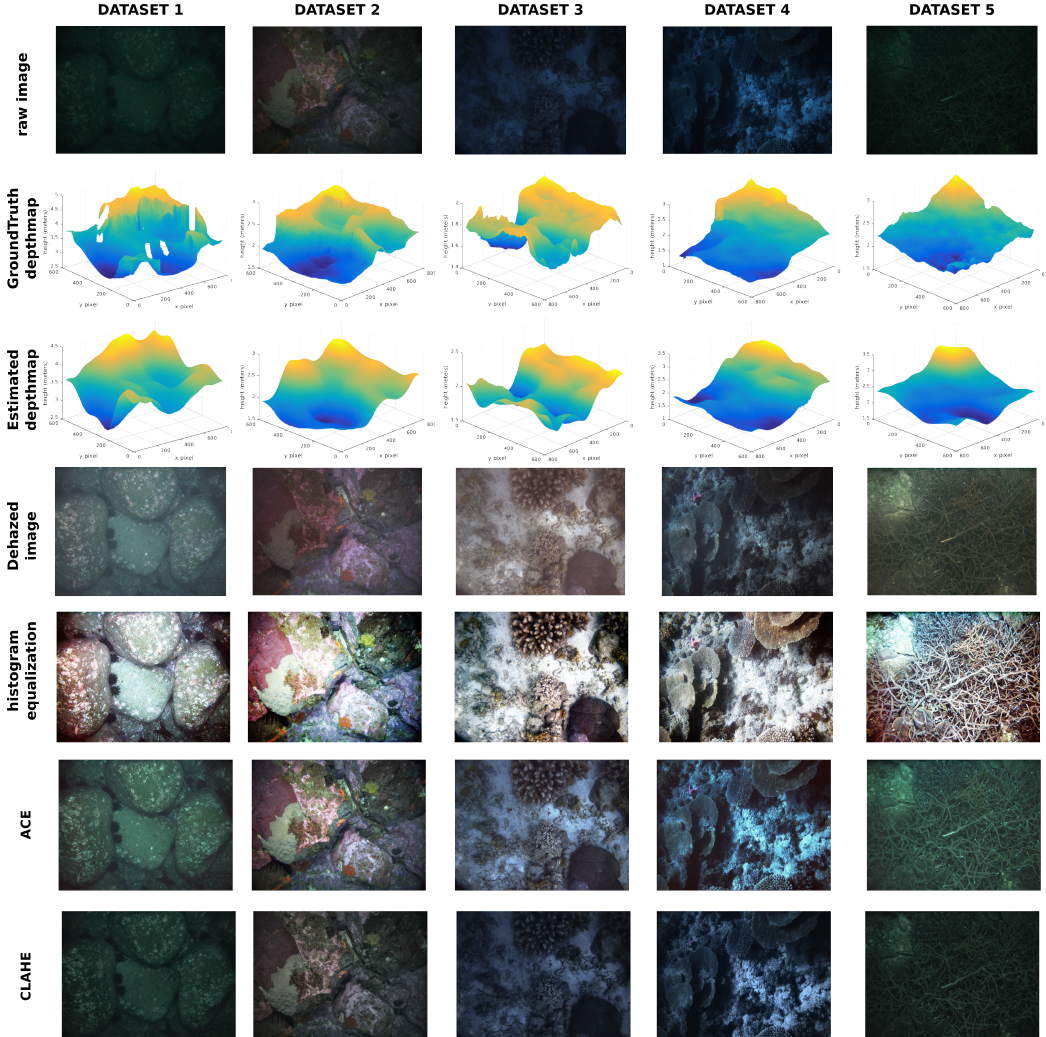
Figure 6. Neural network results applied to image dehazing, from left to right dataset images, from top to bottom raw image, groundTruth depthmap, neural network estimated depthmap, dehazed image using the estimated depthmap, histogram equalized image, Automatic Color Enhancement (ACE), and Contrast Limited Adaptative Histogram Equalization